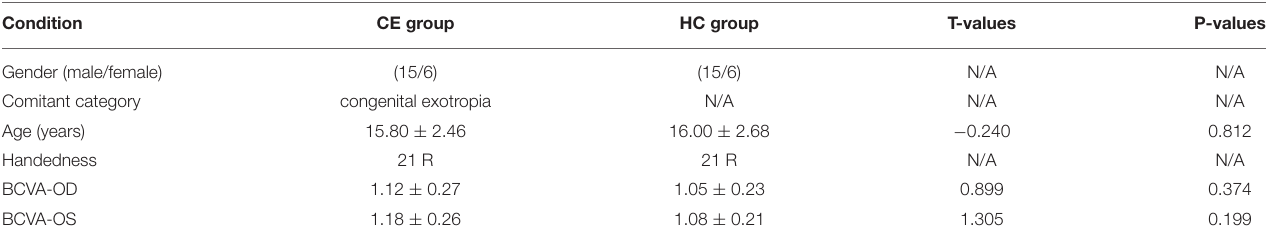
TABLE 1 | Demographics and visual measurements between the two